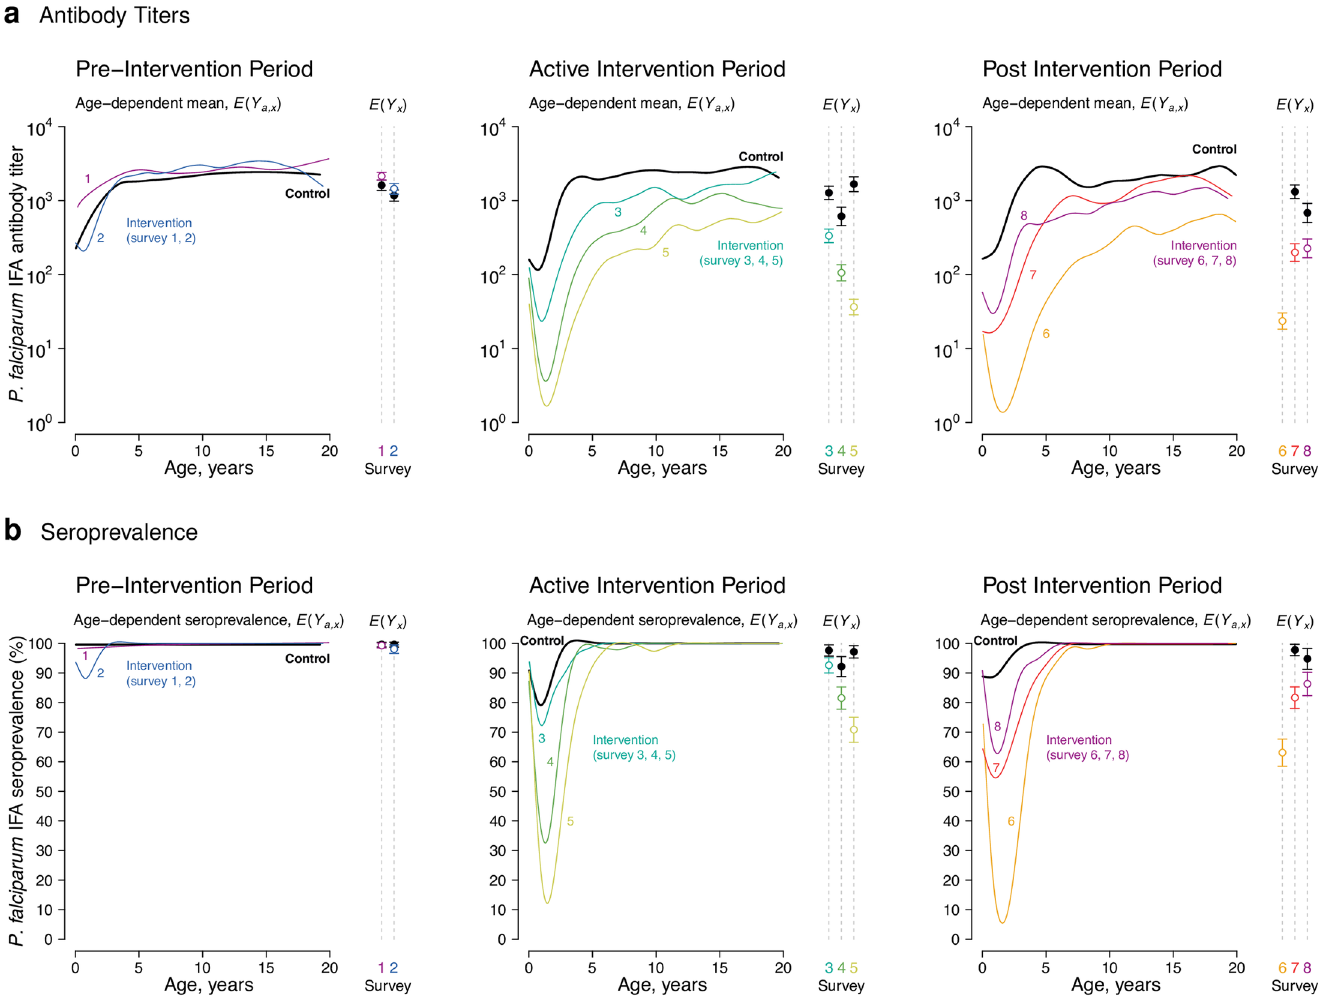
Fig 2. Shifts in the Plasmodium falciparum age-antibody curve measurechanges in malaria transmission due to intervention in the Garki Project, Nigeria (1970–1976). Antibodyresponse measuredwith the IgG indirect fluorescent antibody (IFA) test for P . falciparum using semi-quantitative antibody titers ( a ) or reducedto seroprevalence ( b ). Estimates stratified by pre-intervention periodwet and dry seasons (survey rounds 1–2), active intervention period(survey rounds 3–5, at 20, 50, and 70 weeks followingthe start of intervention), and the post-intervention period (survey rounds6–8 at 20, 40, and 90 weeks followingthe end of the intervention). N = 4,774 total measurements, with 153–442measurements per curve. Controlmeasurements were combinedacross survey rounds within each periodwhen plotting the curves to facilitate visual comparisonof shifts in transmission between surveys. Age-adjusted means by intervention group, E ( Y x ), provide summary differences betweencurves at each survey round. Error bars show 95% confidence intervals for the age-adjusted geometricmeans or seroprevalenceand differences betweengroupsare significantP (cid:20) 0.01 (Bonferroni corrected) for all roundsexcept pre-intervention surveys 1 and 2. Control villageswere not measuredin survey 6. The source data used to generatethis figure are here: https://osf.io/8tqu4(garki), and the scripts used to generate the figure are here: https://osf.io/ek3sx